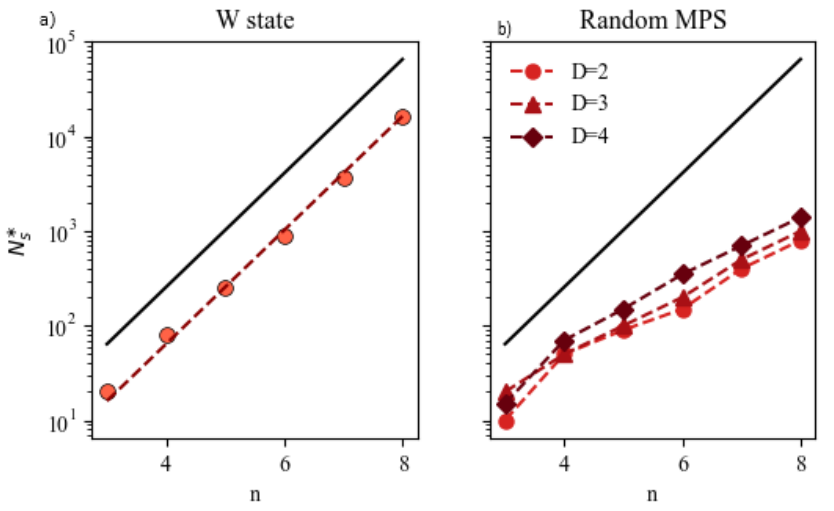
Figure 4. Minimum number of samples N ∗ s required to accurately reconstruct the target quantum state as a function of n for ( a ) the W states and ( b ) the randomly generated matrix product states.The solid black line represents the size of the complete basis set. The dashed line in ( a ) is a linear fit of the average quantum fidelity for the W states. The dashed lines with circle, triangle, and diamond represent results for randomly generate MPSs with D = 2,3, and 4,